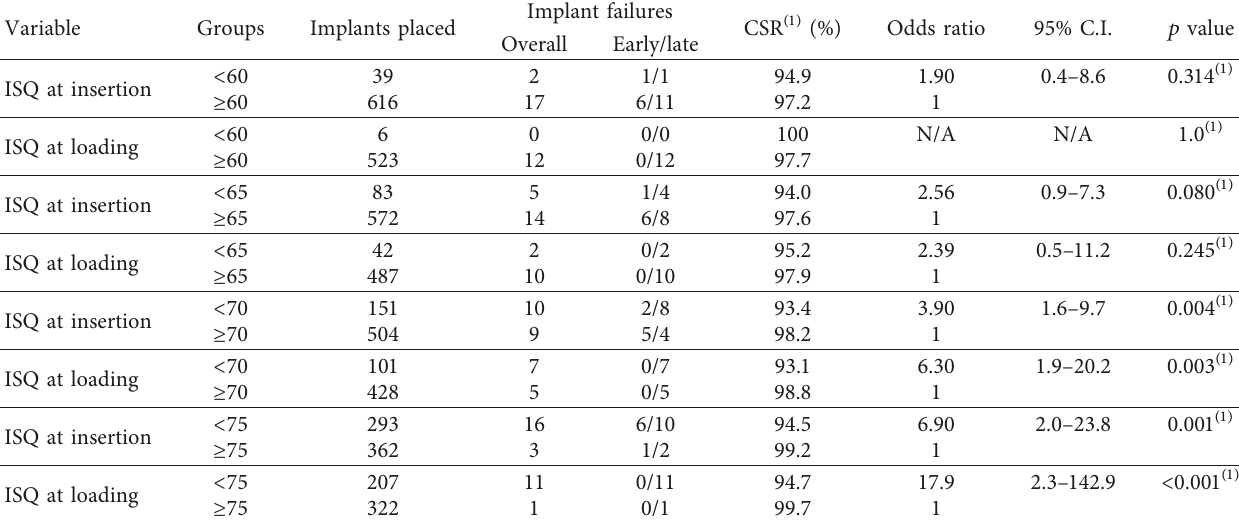
Table 10: Implant survival below and above at different threshold values at implant insertion and loading. Variable